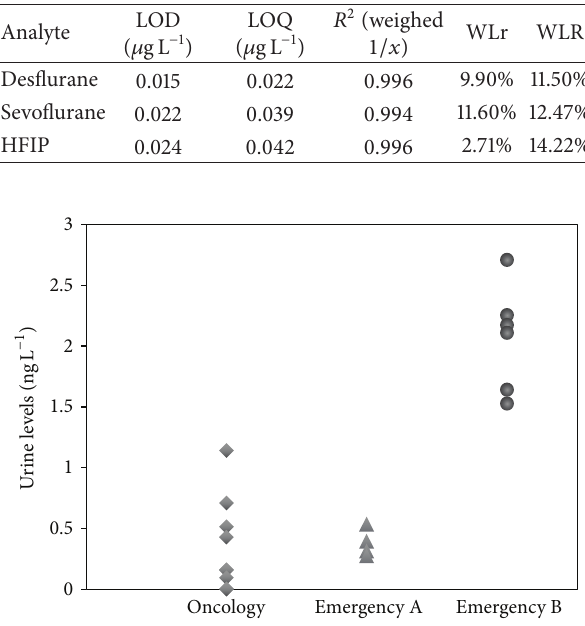
Figure 7: Spread of urinary level increments of desflurane for the different surgery rooms ( ◻ squares: oncology; 󳵻 triangles: emergen- cy A; I circles: emergency